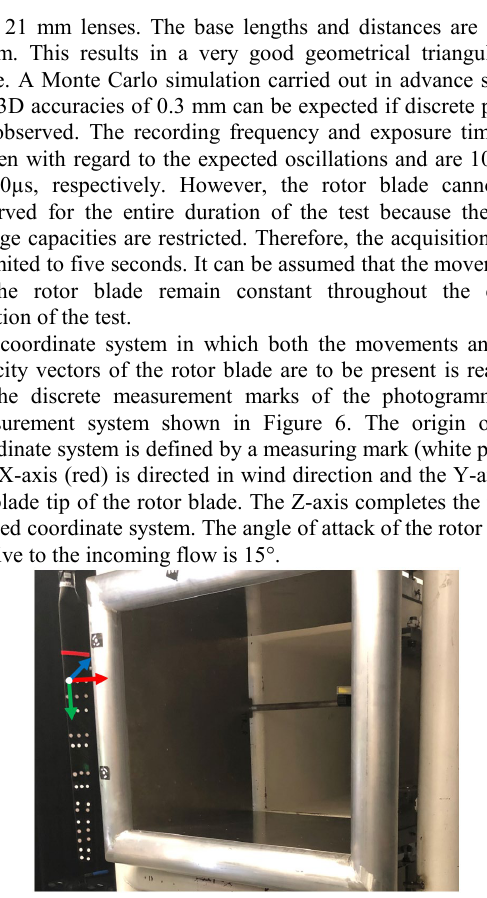
Figure 6. Mounted rotor blade in the wind tunnel; Realisation of the reference coordinate system